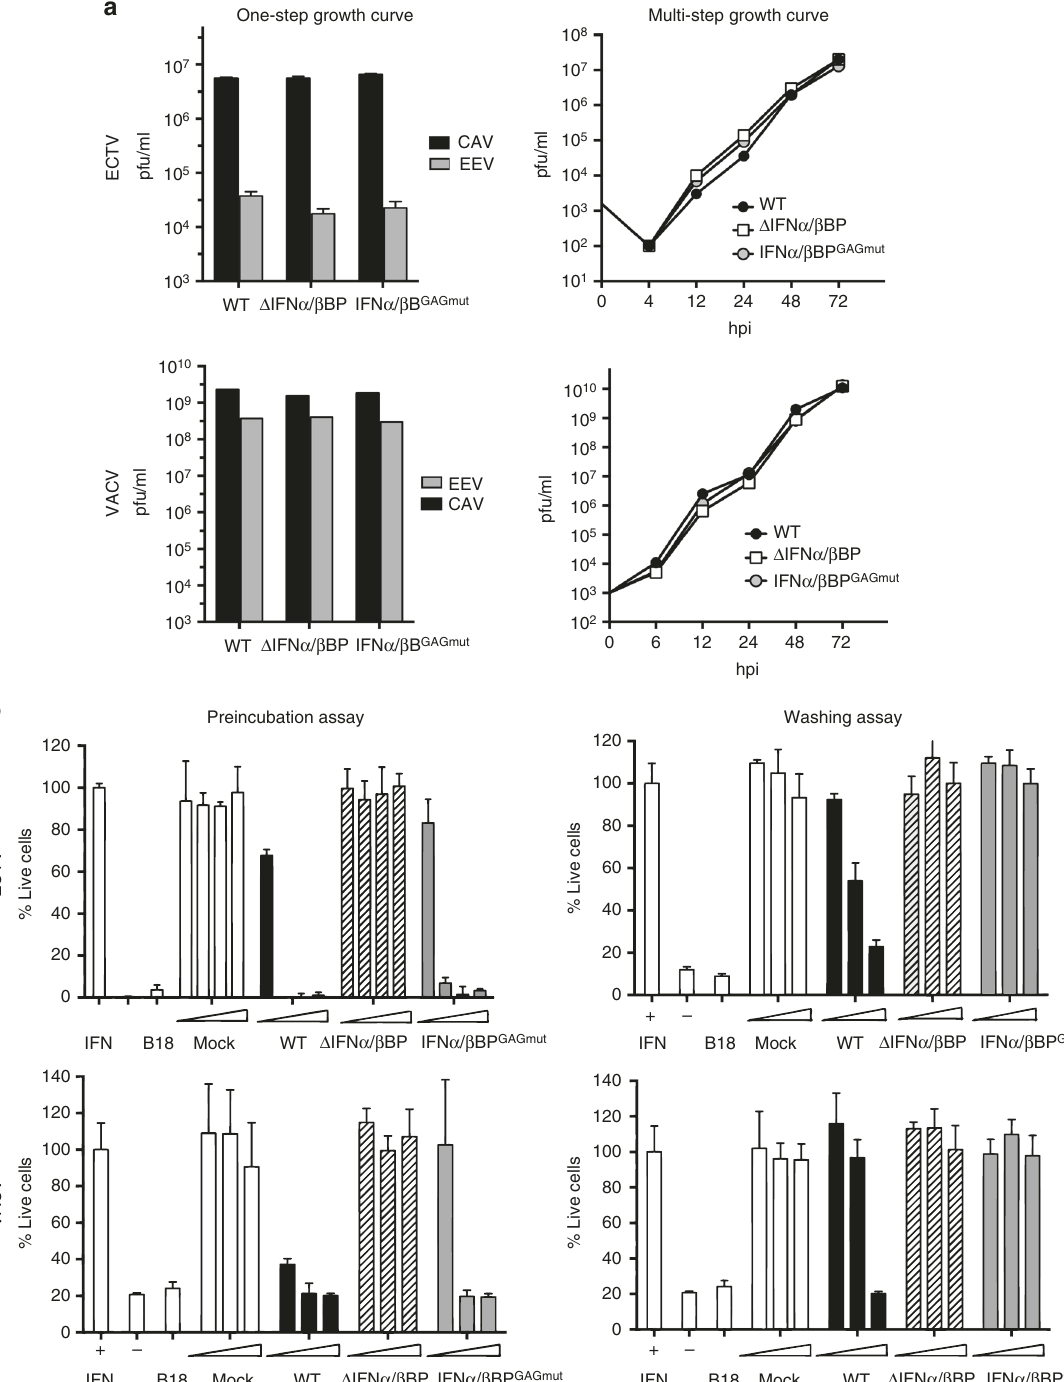
Fig. 3 Characterisation of mutant viruses in cell culture. a BSC-1 cells were infected with the indicated viruses at 0.01 pfu/cell for multi-step growth curves or 5 pfu/cell for one-step growth curves. Total virus production was determined by plaque assay at the indicated times in the multi-step growth curve. Virus titres at 24 hpi from fractions containing cell associated viruses (CAV) or extracellular viruses (EV) where determined in the one step growth curves. b Detection of IFN-I blocking activity in supernatants from recombinant ECTV (upper graphs) or VACV (lower graphs) infected cells was performed using the previously described preincubation (left) or washing (right) assays. In both assays, controls of untreated (IFN -) or IFN-I treated cells (IFN + ) and also B18 recombinant protein were incorporated as positive control. Data are means showing standard deviations of two independent experiments performed in